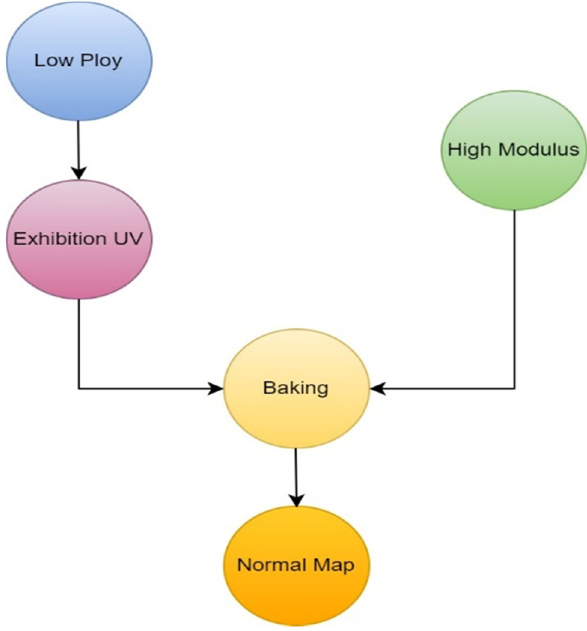
Figure 8: Baking normal mapping